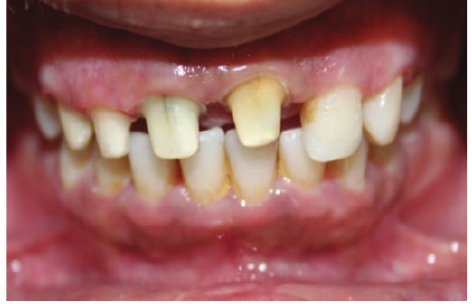
Figure 15: Tooth preparation.